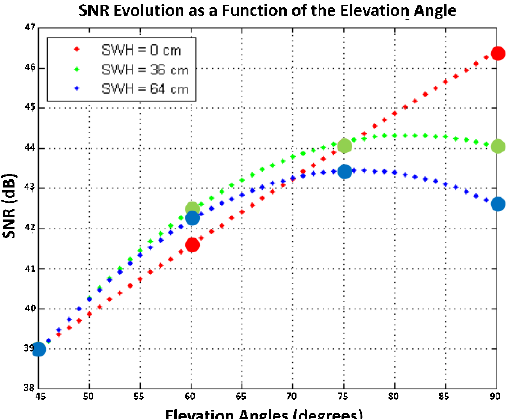
Figure 14. SNR of the reflected signal for three different surface states and for an elevation angle in the range from θ approximation of the experimental data over elevation angles at θ and θ = e